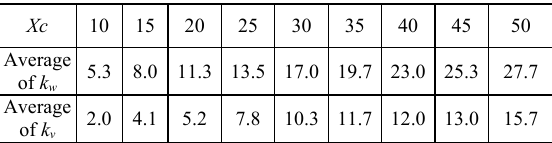
Figure 8. Average reduction of the SRS time spent. Table 4. Average k w and k v for each Xc.